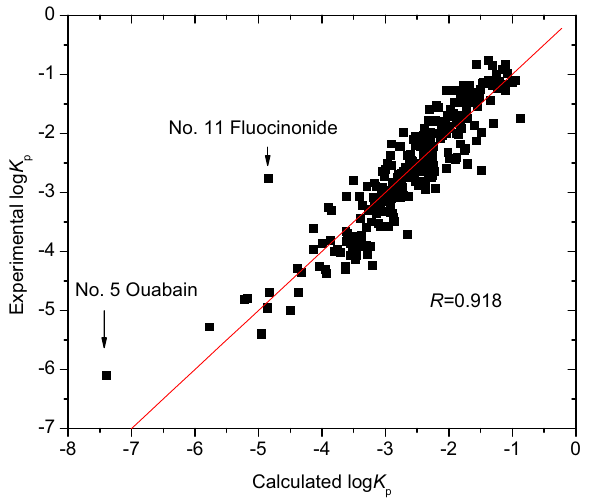
Figure 2. Plot of experimental versus calculated log K p with Eq. (12), generated by OriginPro 7.5